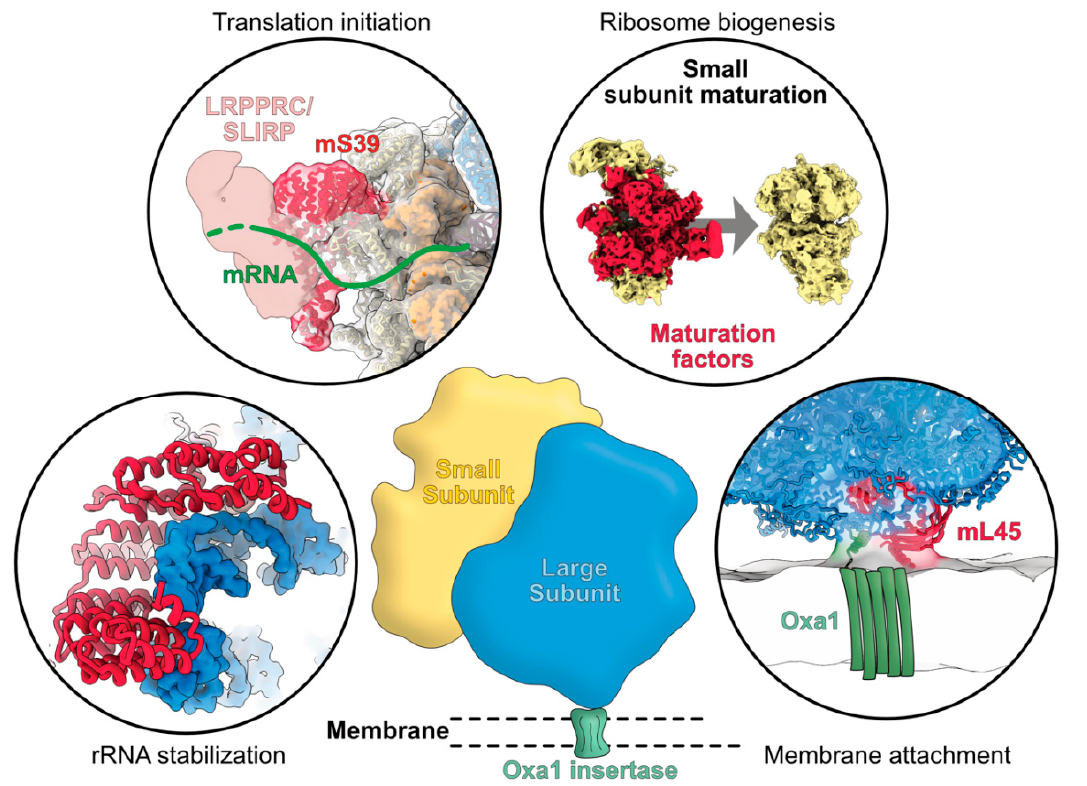
Figure 2. Graphical summary of the functions of mitoribosome-specific ribosomal proteins. The recently identified proteins specifically occurring in mitochondrial ribosomes are shown in red. They can be involved in rRNA stabilization, in the recruitment of mRNA for translation initiation, in the assembly and maturation of mitoribosomes, and in its attachment to the mitochondrial inner membrane through the binding with the insertase Oxa1. The exemplary shown mS39 and mL45 specifically occur in mammalian mitoribosomes.